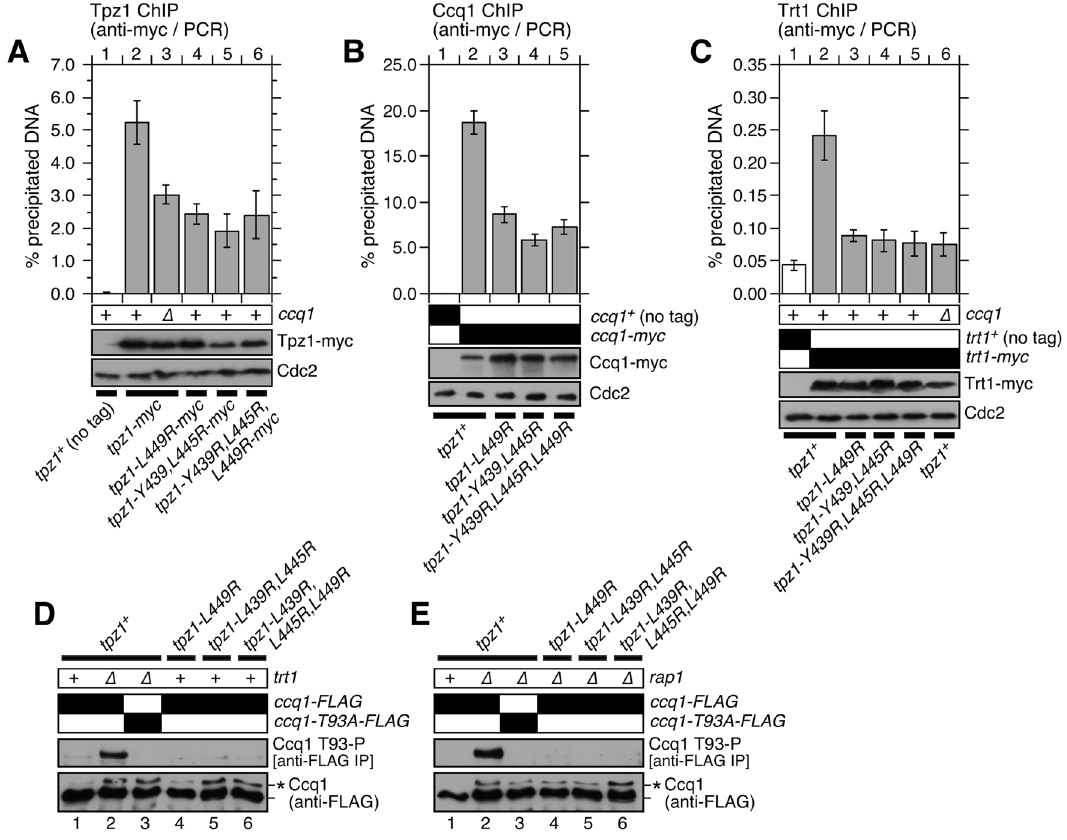
Figure 5. Telomere association of Tpz1, Ccq1 and Trt1 TERT in Tpz1-Ccq1 interaction mutant cells. Effects of disrupting Tpz1-Ccq1 interaction on telomere association for ( A ) Tpz1, ( B ) Ccq1 and ( C ) Trt1 TERT were monitored by ChIP assays. Error bars represent standard error of the mean from three to nine independent experiments. Statistical analysis of ChIP data by 2-tailed Student’s t-test is shown in Table S5. Southern blot analyses of telomere lengths for strains used in ChIP assays are shown in Figure S8A–C. Expression levels of myc-tagged proteins were monitored by anti-myc western blot analysis of whole cell extracts. Anti-Cdc2 blots served as loading control. ( D – E ) Ccq1 Thr93 phosphorylation, detected by anti- phospho(S/T)Q (Phospho-(Ser/Thr) ATM/ATR substrate antibody in both rap1 + (D) or rap1 D (E) backgrounds, is abolished in Tpz1-Ccq1 interaction disruption mutants. For anti-FLAG blots, asterisk (*) indicates hyper-phosphorylated form of Ccq1.